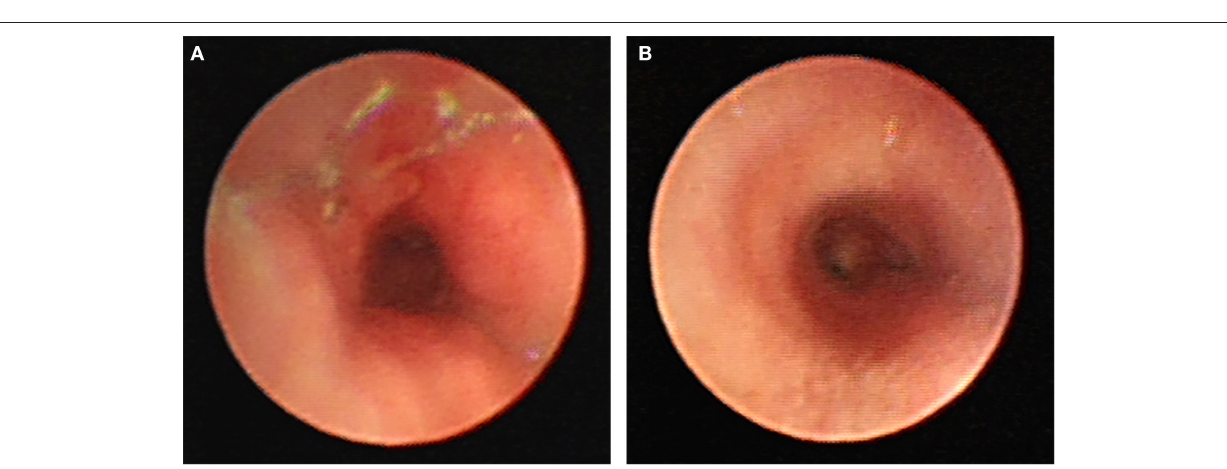
FIGURE 3 | Contrast before (A) and 1 week after (B) stent